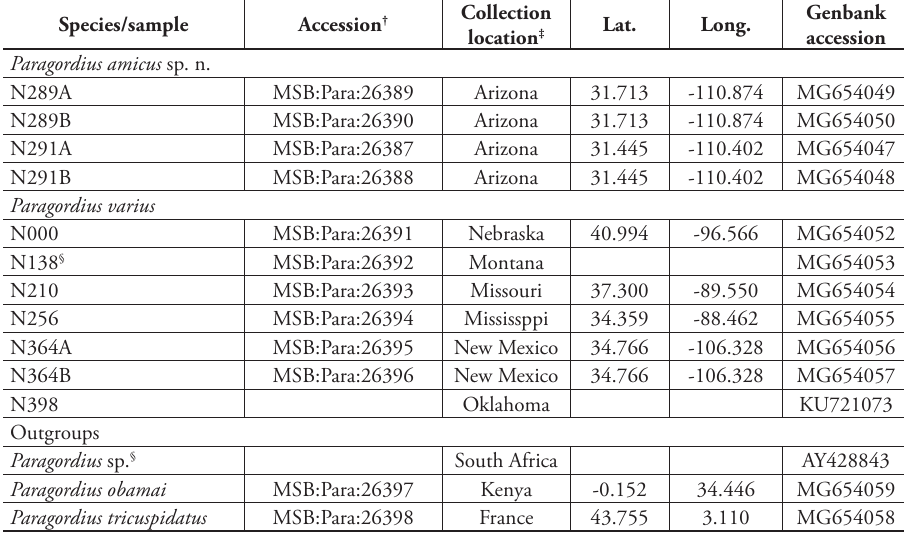
Table 1. Collecting location for hairworm samples used in this